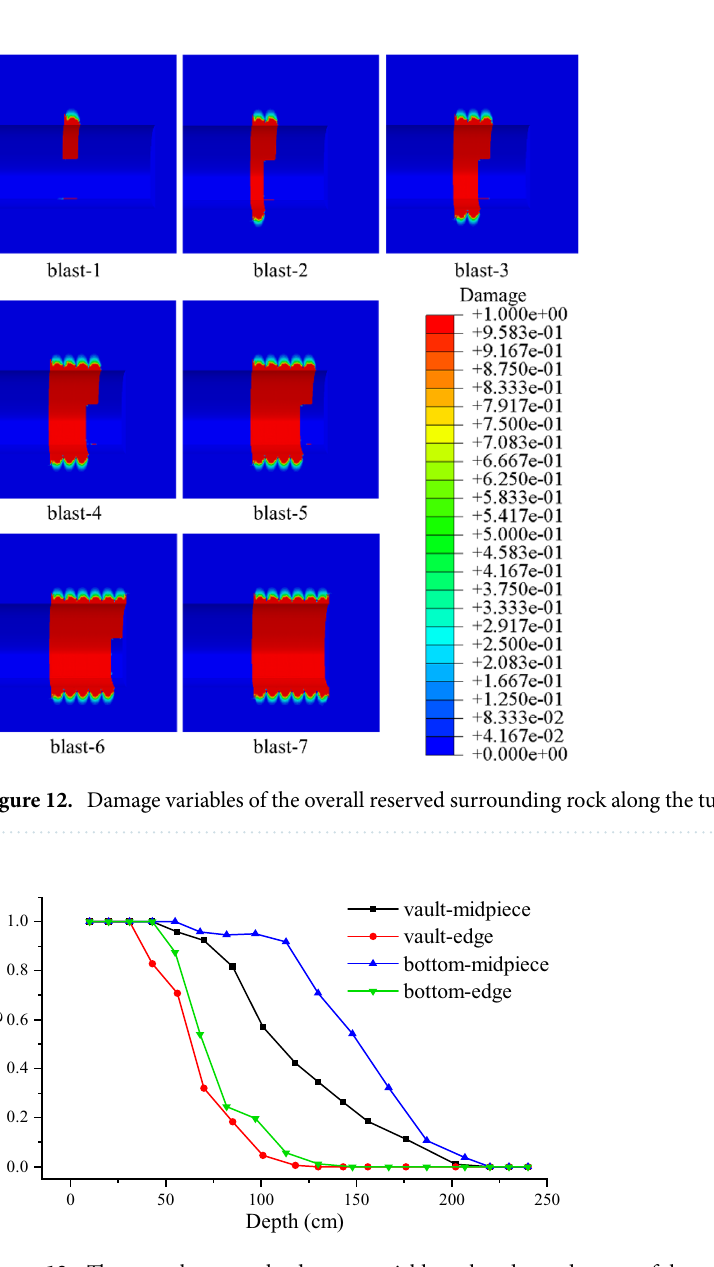
Figure 13. The curve between the damage variable at the edge and center of the periodic damage area and the